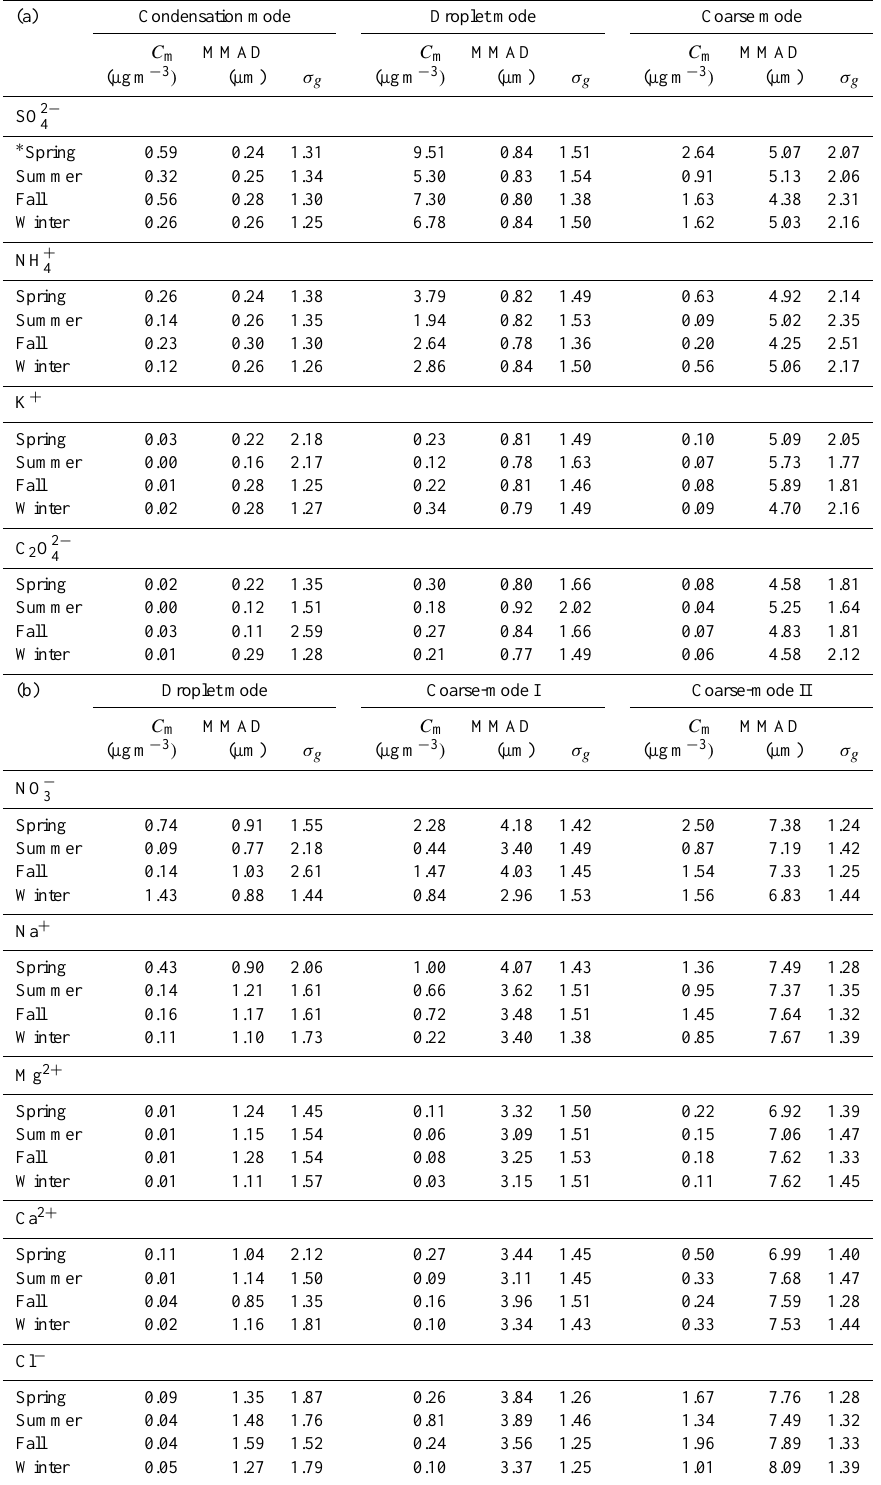
Table 1. Mass mean aerodynamic diameters (MMAD, µm), standard deviation ( σ g ) and modal concentrations of ionic species ( C m , µgm − 3 ) in spring ( N = 8, N represents number of samples), summer ( N = 11), fall ( N = 13) and winter ( N =